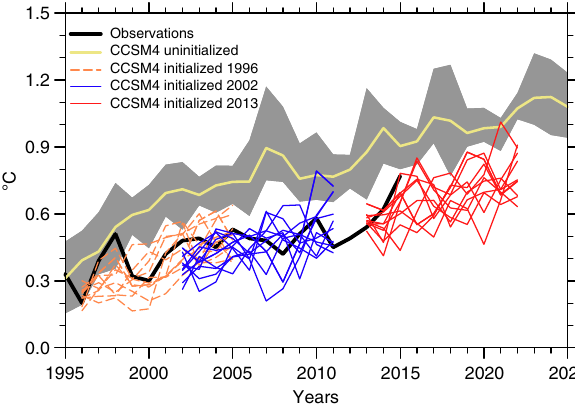
Figure 5 | Time series of global surface air temperature anomalies. Annual mean surface temperature anomalies ( (cid:2) C) relative to observed climatology of 1960–1990 for the CCSM4 uninitialized six member ensemble average (solid yellow line) and the envelope of individual ensemble simulations (grey shading); annual mean values from observations is solid black line 25 ; individual ensemble member time series for 10-year predictions initialized 1 January 1996 (dashed orange lines) to capture the late-1990s transition from positive to negative IPO 4 , an example of predictions for the hiatus initialized 1 January 2002 (blue lines) and predictions initialized on 1 January 2013 (red lines), the latter showing larger predicted warming rates than the former during the